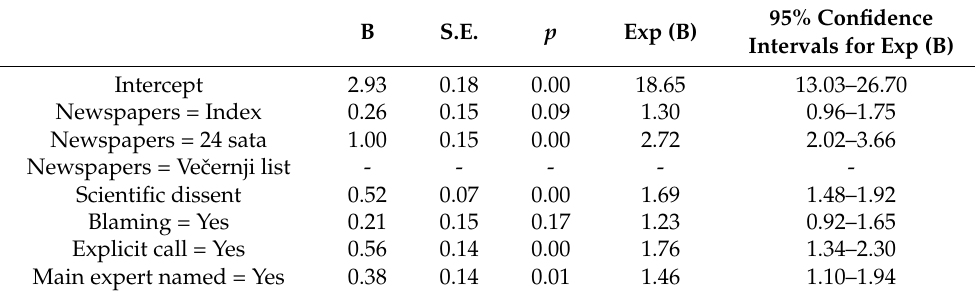
Table 4. Negative binomial regression—model 1.